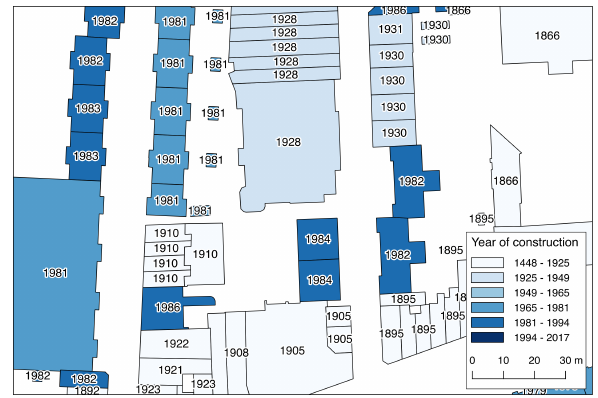
Figure 1. Building footprints with the values of the year of con- struction in the cadastral database of the City of Rotterdam and Dutch